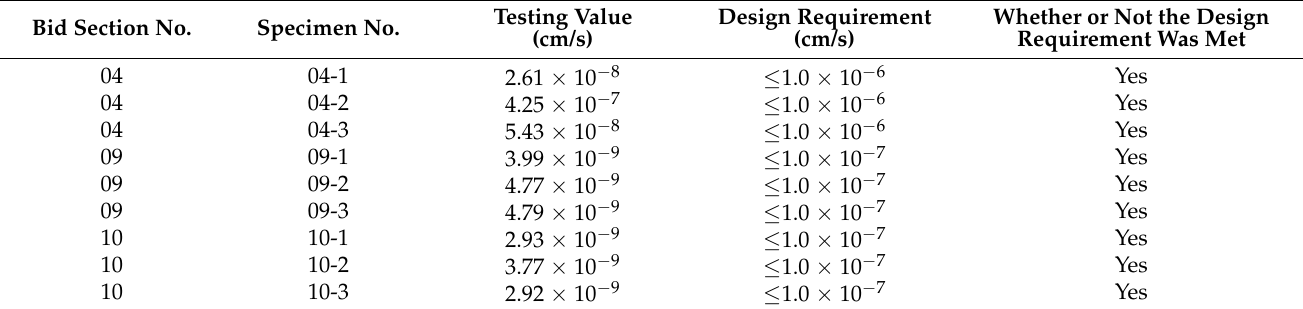
Table 6. Results of the seepage coefficient of cement–soil mixing piles. Design Requirement Testing Value Bid Section No. Specimen No. (cm/s)